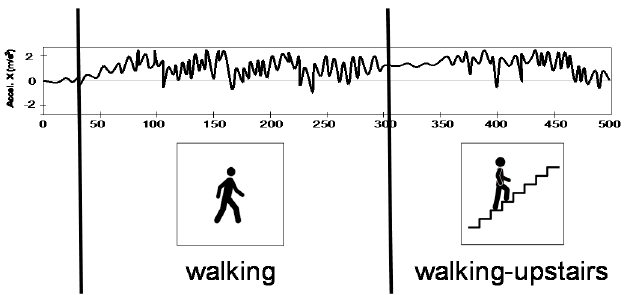
Figure 4. Example of activity recognition and segmentation.